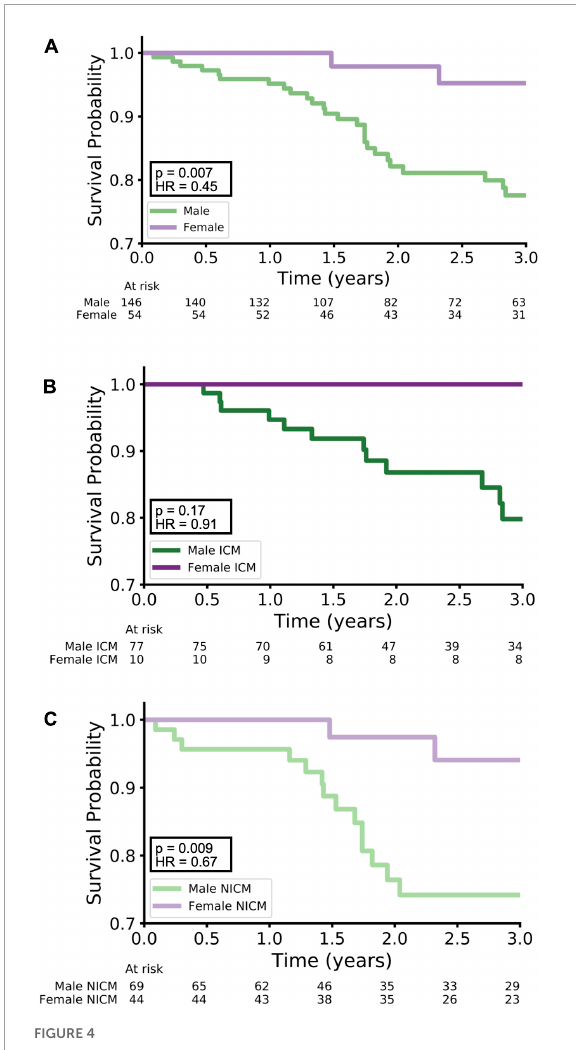
FIGURE4 Kaplan–Meier survival curves. Kaplan–Meier curves for survival are shown with stratification by: (A) males vs. females, (B) males with ICM vs. females with NICM, and (C) males vs. NICM versus females with NICM. Females had better survival than males ( A , p = 0.007, HR = 0.45), and females with NICM had better survival than males with NICM ( C , p = 0.009, HR = 0.67). There was no significant difference in survival between females with ICM and males with ICM ( B , p = 0.17, HR = 0.91).